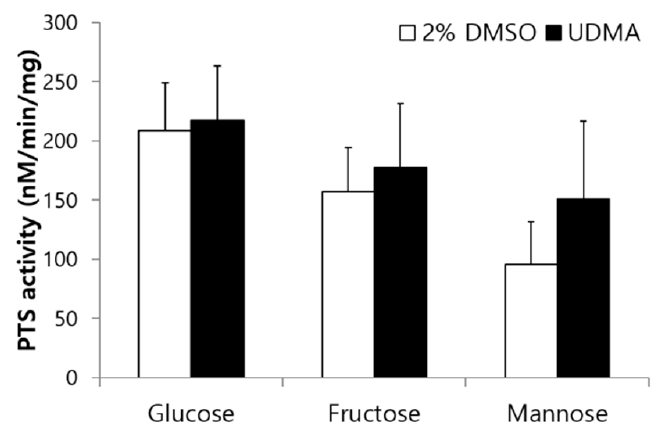
Figure 7. Sugar ‐ specific phosphotransferase activity of S. mutans UA159 grown in the presence and absence of UDMA. DMSO was used as a vehicle for UDMA, and cells grown in the absence of UDMA (2% DMSO) were used as the control. The data are expressed as mean ± standard devia ‐ tion values. In the glycolytic pH drop assays using glucose as the sole substrate, UDMA-treated cells exhibited retarded glycolysis compared to the control (Figure 8a). In addition, cells grown in the presence of UDMA exhibited a higher final pH than that of the control (Figure 8a). The tendency for a drop pH in the absence of external glucose indicated that cells grown in the presence of UDMA experienced a rapid decrease in pH during the initial stage, followed by a rapid recovery to the final pH (Figure 8b), suggesting that cells grown in the presence of UDMA stored a smaller amount of intracellular polysaccharides than those grown in its absence.